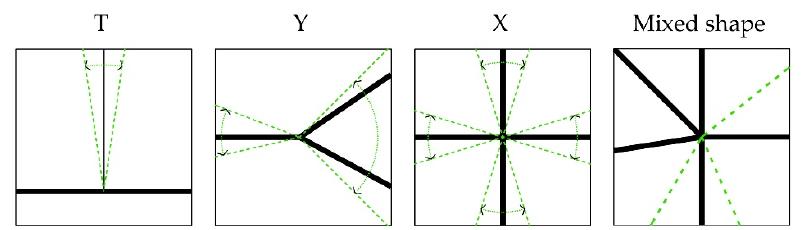
Figure 4. Types of the emerging junctions.